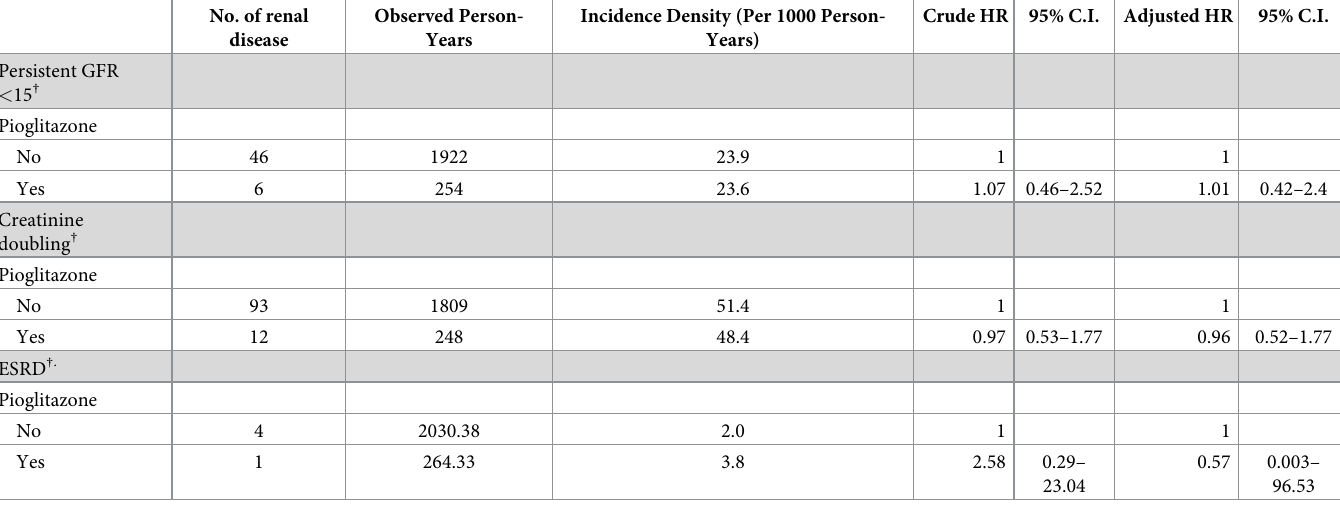
Table 4. Risk of primary renal outcome in patients taking Pioglitazone based on Cox proportional hazard model. No. of renal